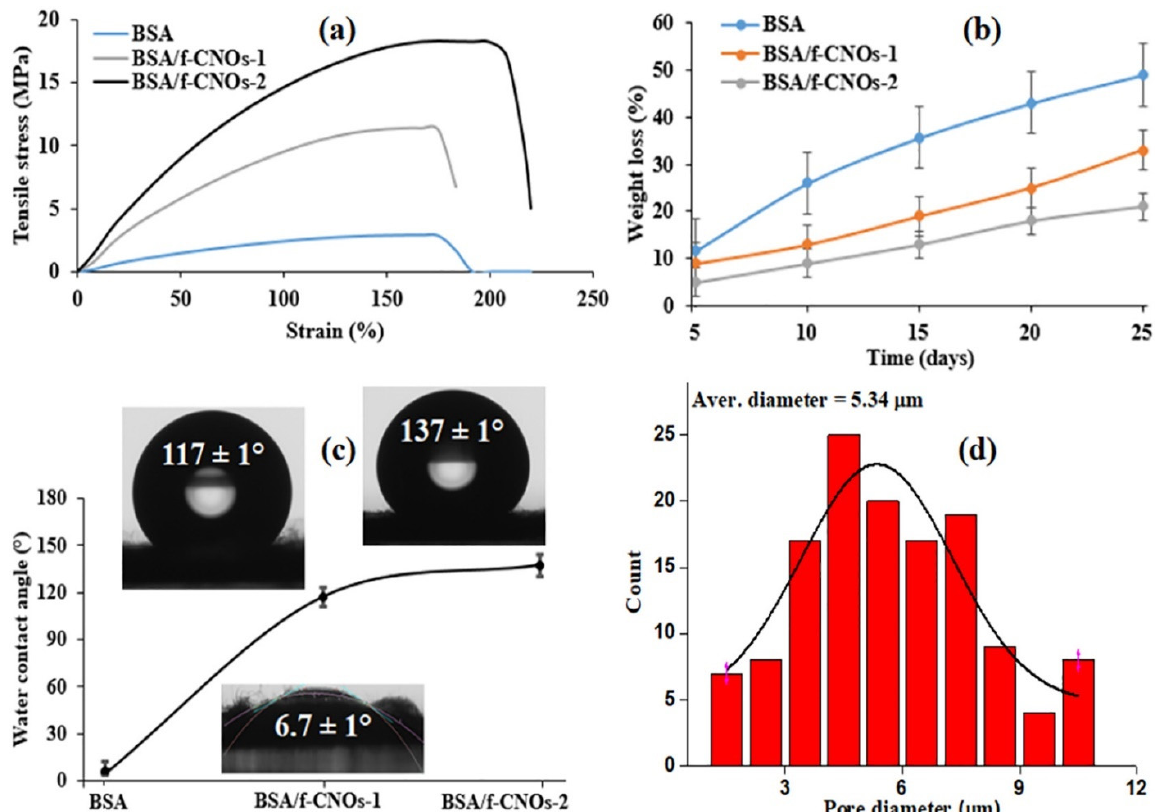
Figure 8. ( a ) Tensile strength; ( b ) degradation; ( c ) water contact angle for virgin BSA, BSA/f-CNOs-1, and BSA/f-CNOs-2 filaments; ( d ) porosity/permeability of biomimetic or biocompatible BSA/f-CNOs-2 nanocomposite fibrils. Reproduced with permission from [298].